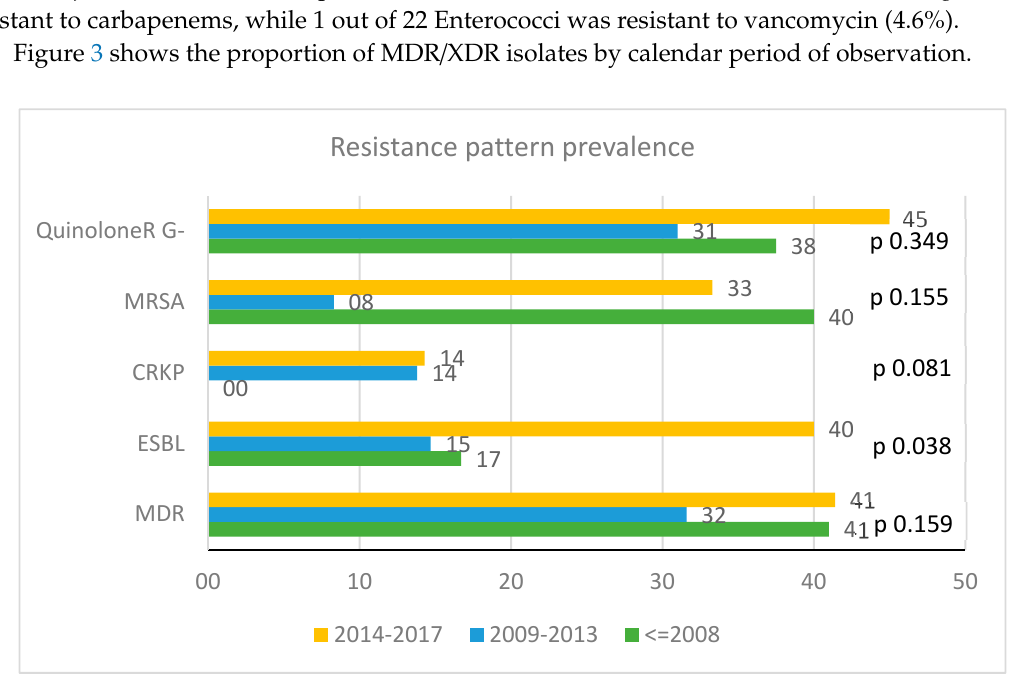
Figure 3. Proportion of multidrug-resistant (MDR)/extensively drug resistant (XDR) isolates by calendar period. Rates of resistance of Quinolone R, carbapenem-resistant K. pneumoniae (CRKP) and extended-spectrum beta-lactamase (ESBL) pattern are defined within Enterobacteriaceae. Rates of methicillin-resistant S. aureus (MRSA) are defined within Staphylococcal infections. MDR: multidrug resistant; ESBL: extended-spectrum beta-lactamase; CRKP: carbapenem-resistant K. pneumoniae ; MRSA: methicillin-resistant S. aureus .